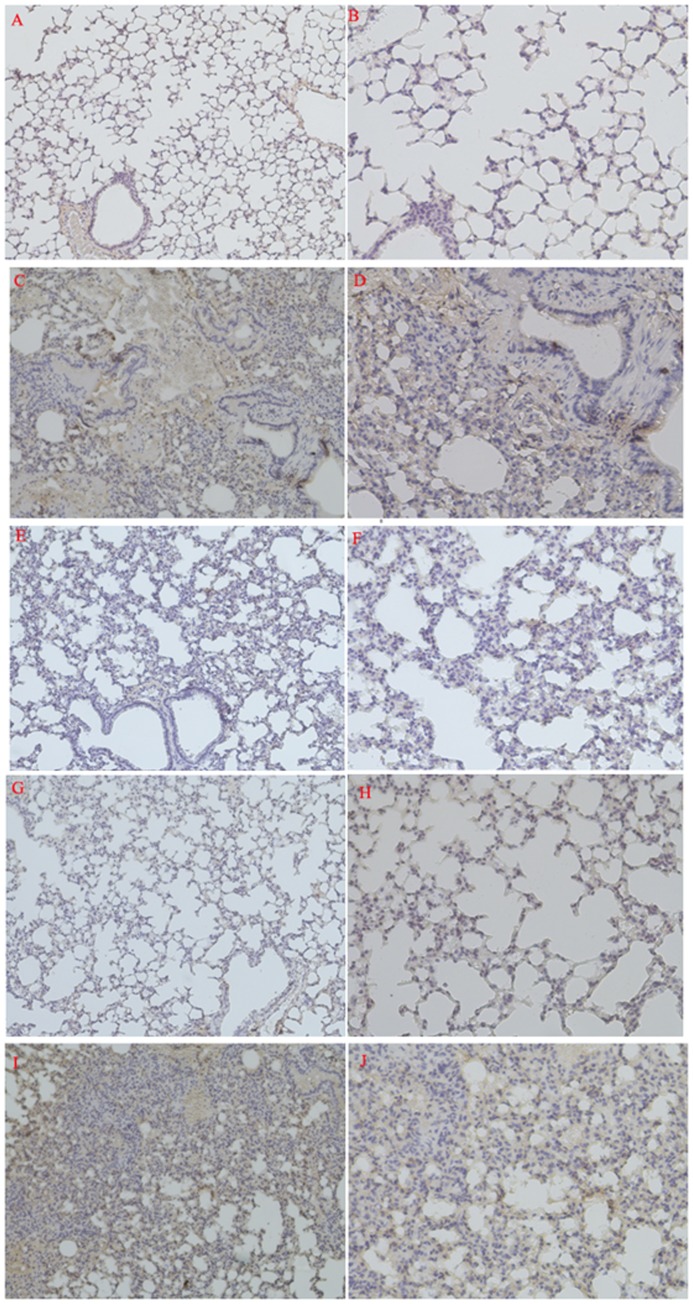
Photomicrographs of representative immunostained sections of lung.(A, C, E, G, I: magnification ×100; B, D, F, H, J: magnification ×200). A, B: Saline group treated with physiologic saline only. C, D: LPS group without any other treatment. E, F: LPS group treated with rHDLwt. G, H: LPS group treated with rHDL74. I, J: LPS group treated with rHDL228. Compared with the saline group (A, B), mice in the LPS group (C, D) exhibited a higher expression of NF-κB p65, as shown by the arrows. Compared with the LPS group, rHDLwt (E, F) significantly decreased the expression of NF-κB p65. There was almost no positive expression of NF-κB p65 in the mice in the LPS group treated with rHDL74 (G, H). Mice receiving rHDL228 (I, J) showed aggravated expression of NF-κB p65. To confirm our experimental results, we performed three independent experiments.